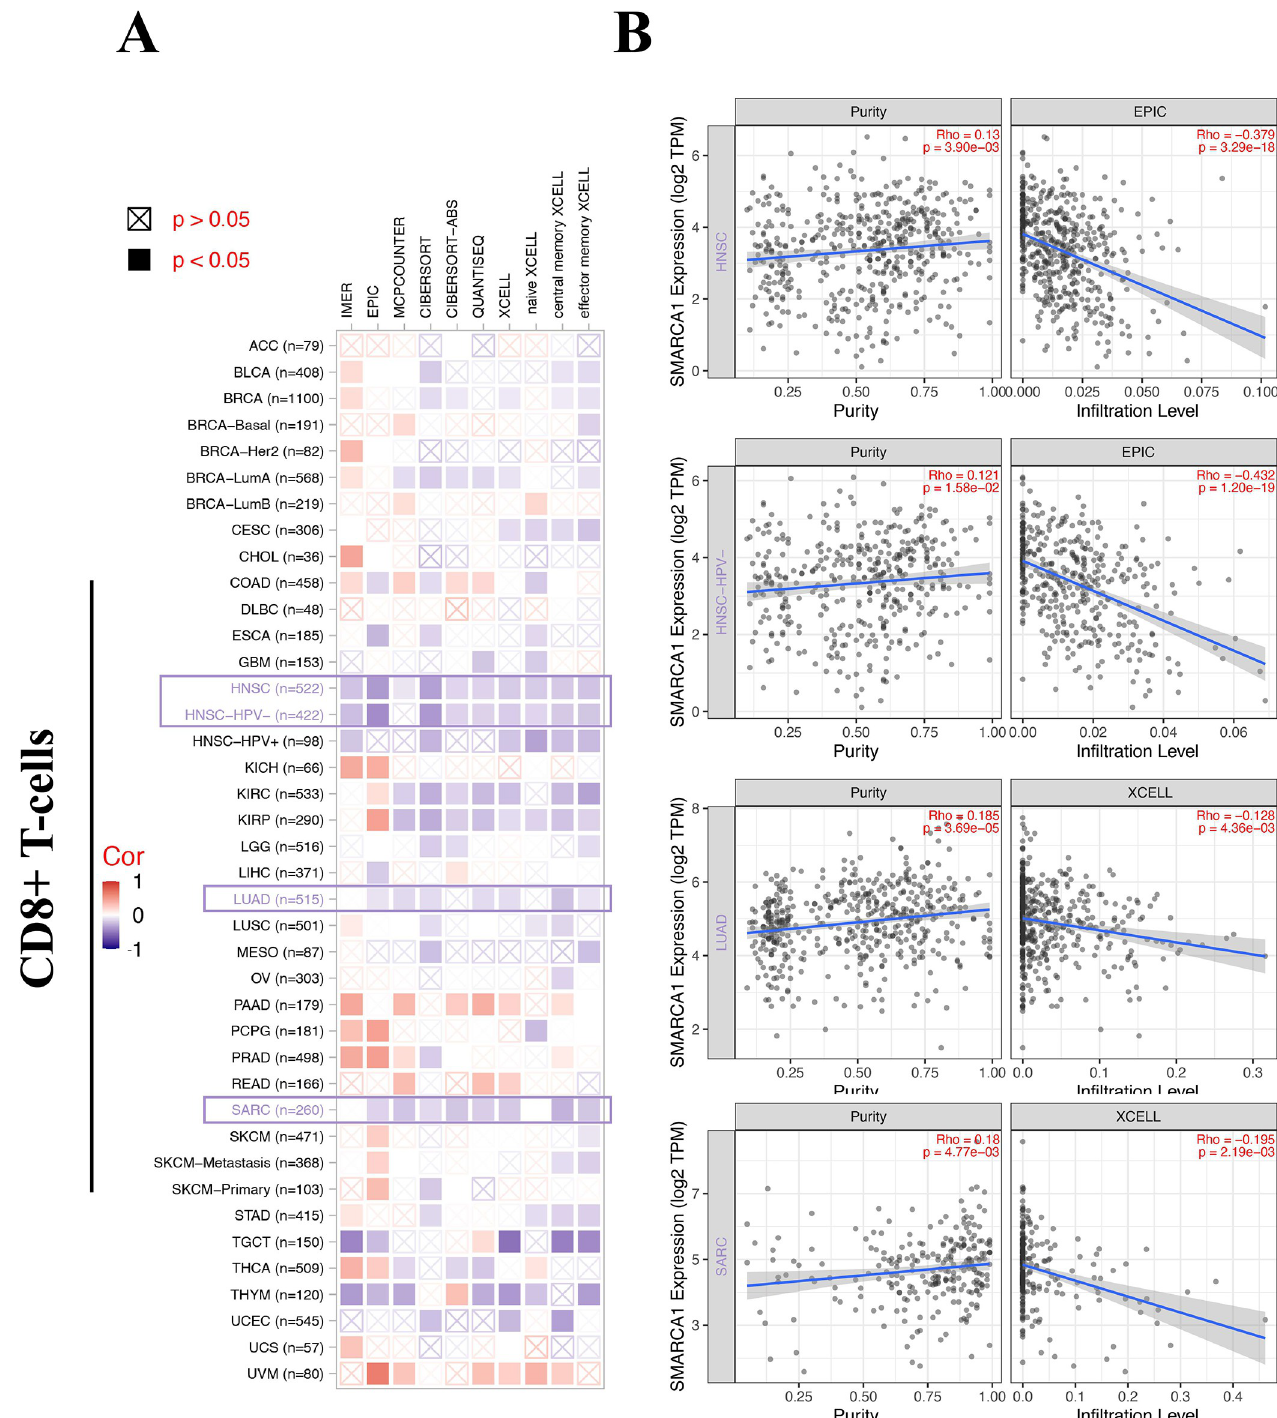
Fig 11. Correlation analysis between SMARCA1 expression and CD8 + T-cells infiltration. (A) Heatmap of correlation between SMARCA1 and the tumor- related immune infiltration level of CD8 + T-cells among all cancers in TCGA with diverse of algorithms; (B) correlation analysis of HNSC, HNSC-HPV, LUAD and